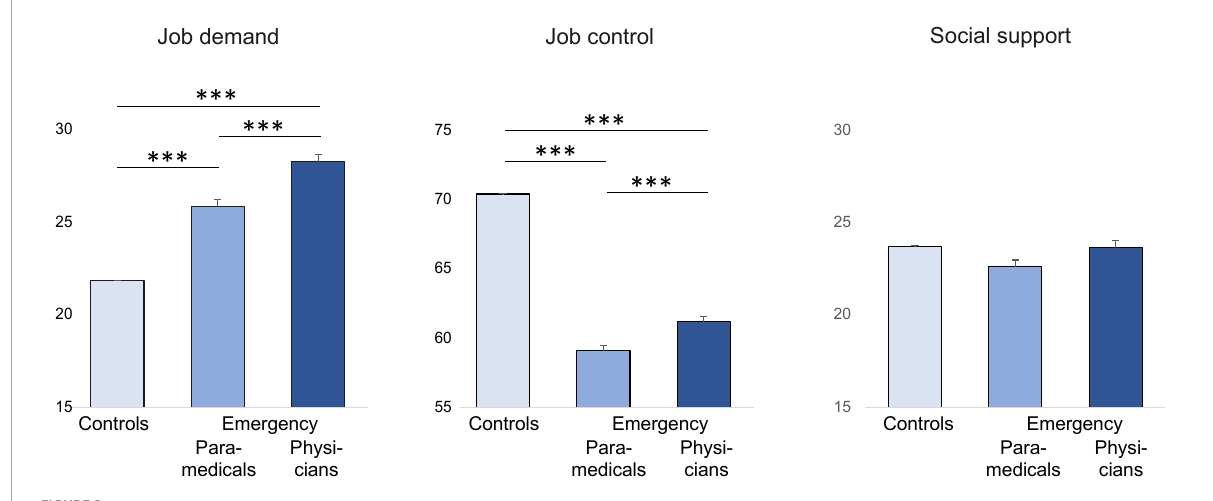
FIGURE2 Comparison of job demand, job control, and social between controls (SUMER), paramedics, and emergency physicians from emergency departments. ∗∗∗ p < 0.001. Results are significant if p < 0.05.